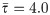
Interspike-times histograms of a combined data set of 7 different cells.
f
7(δt) (A) and f
7(δτ) (C), and frequency-count histograms P
7(k) (for a time interval T = 2.5 s) (B) and P
7(κ) (for a rescaled time interval τ¯=4.0 (D)) before and after time-rescaling. The histograms f
7(δt) and f
7(δτ) are fitted with gamma (solid lines) and exponential distributions (dashed lines). The frequency-count histograms P
7(k) and P
7(κ) are fitted with the gamma-count (see text, solid lines) and Poisson distributions (dashed lines). Inset plots in (A) and (C) show the spike rates of the original and time rescaled spike series, respectively. The number of spikes used was 4252.